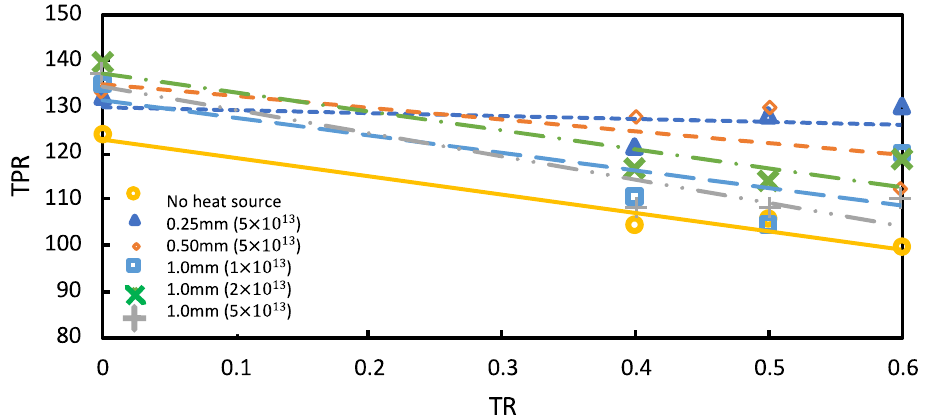
Figure 10. Total pressure recovery in steady-state condition at various diameters and powers of heat source.